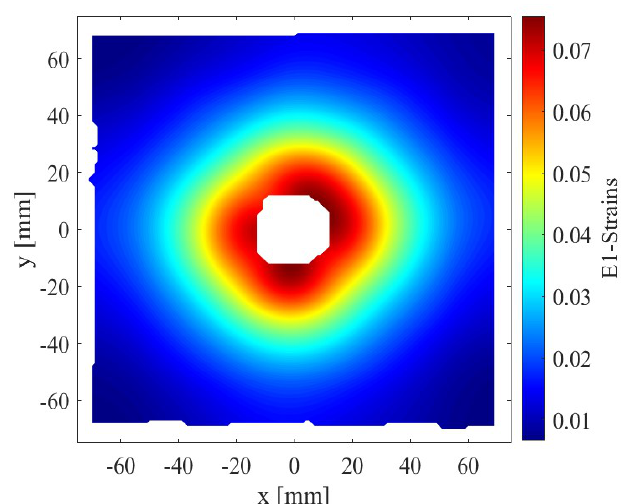
Figure 17. Illustration of the major principal strains for blast-loaded aluminum plate (configuration 2 test